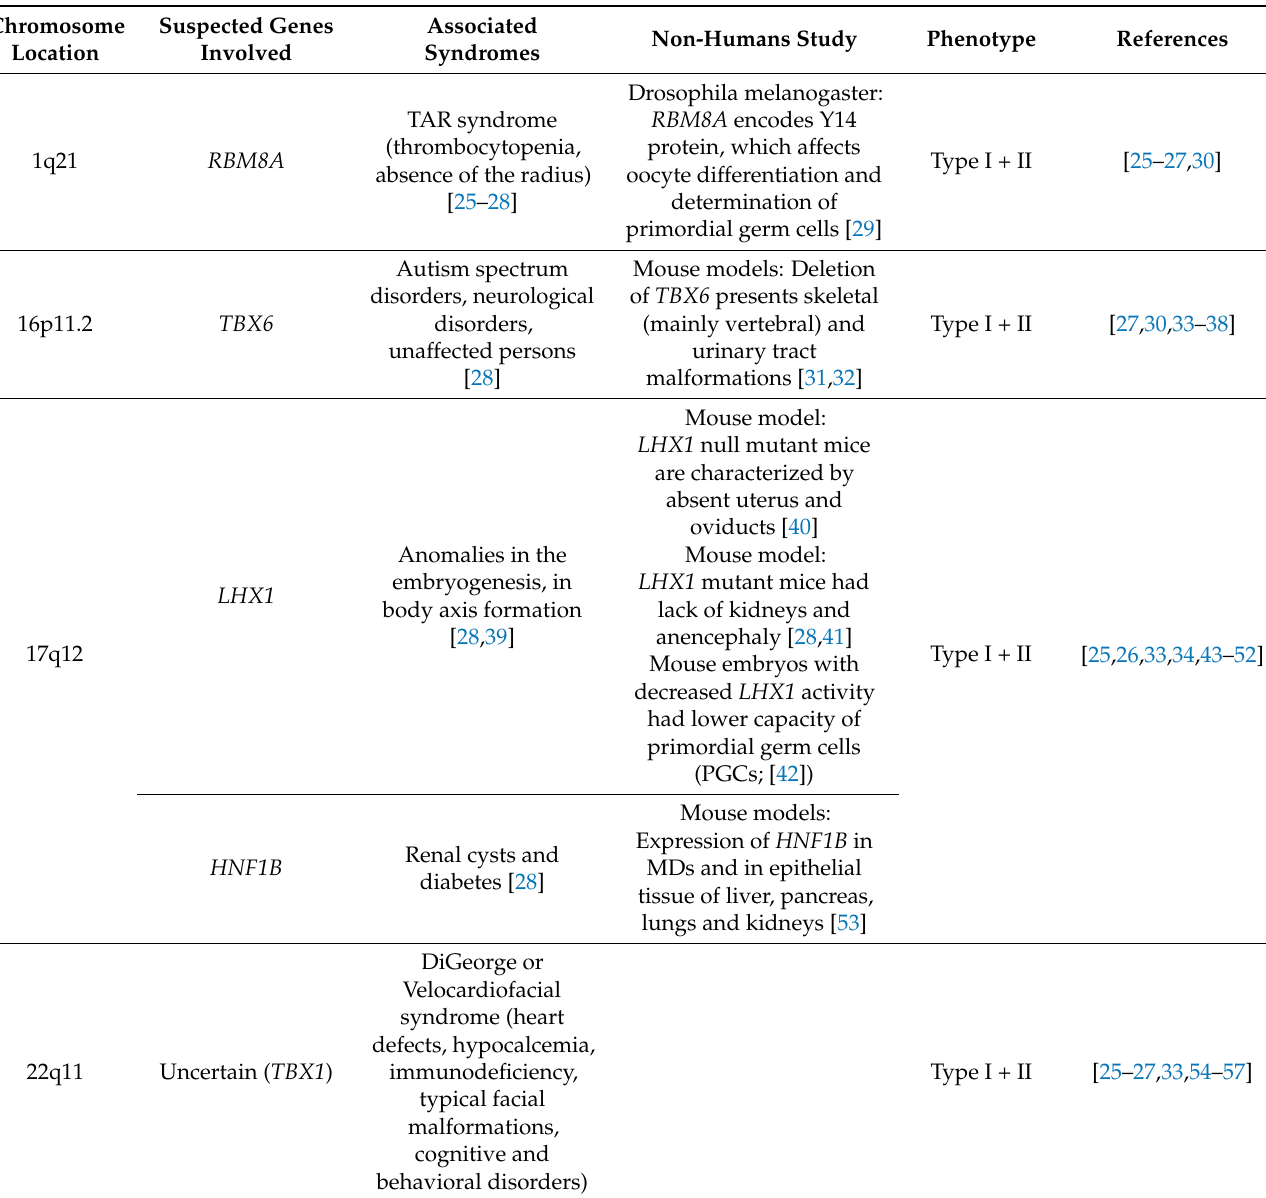
Table 1. The most common chromosomal regions and genes associated with MRKH, their associated clinical presentation, animal studies of these genes, and phenotype of MRKH related to defects in these